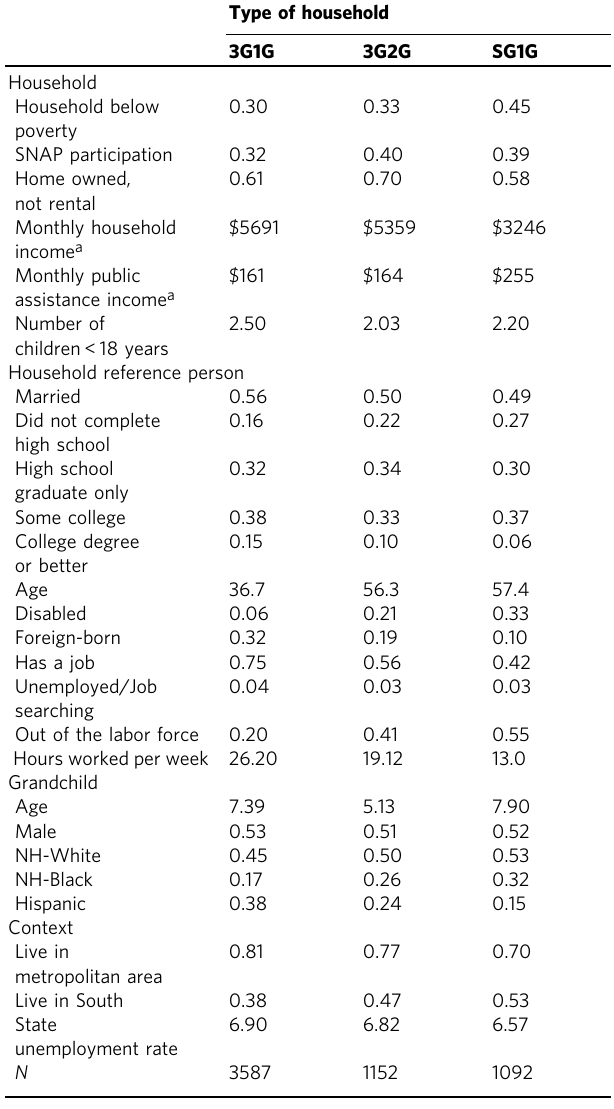
Table 1 Characteristics of intergenerational households, by focal generation heading the